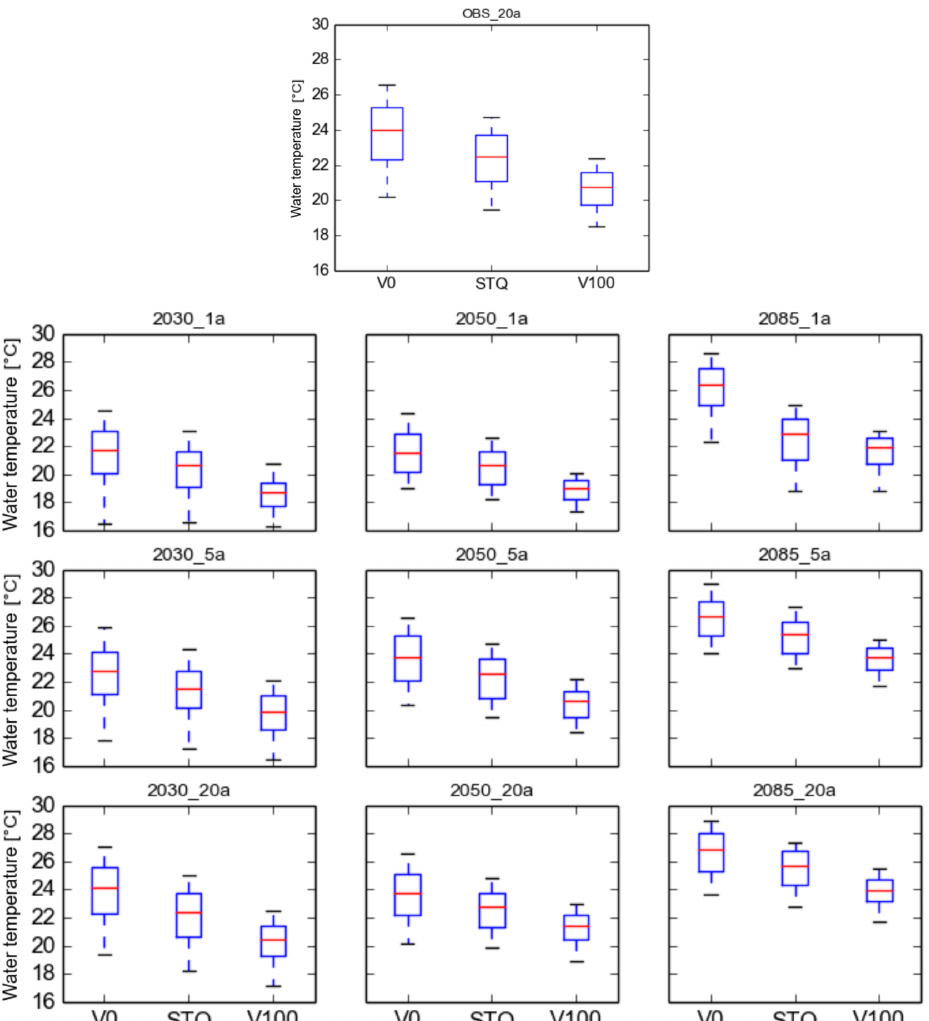
Figure 4. Box-and-whisker plots showing the 5-day mean water temperature distributions during the 1a, 5a and 20a episodes for the climate periods centred on 2030, 2050, 2085 with mean low flow discharge at DFS 39km. The hourly values of V0 (no vegetation) and V100 (full vegetation) are significantly different from STQ in all episodes ( p< 0 .